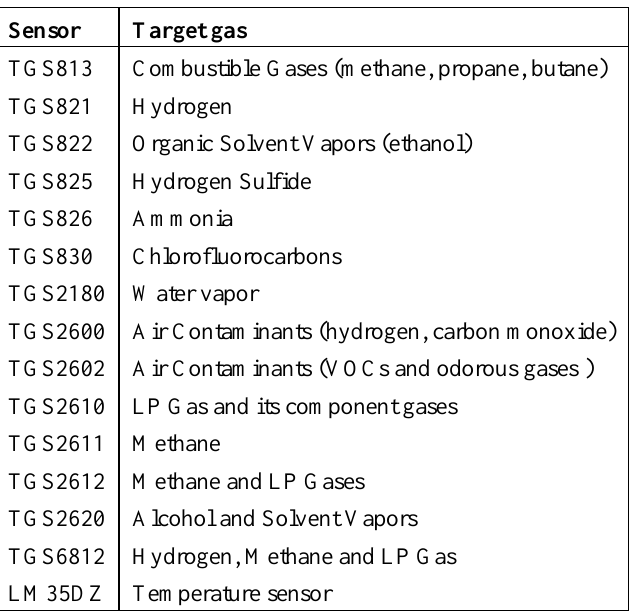
Table 1. List of sensors used to develop the E-nose